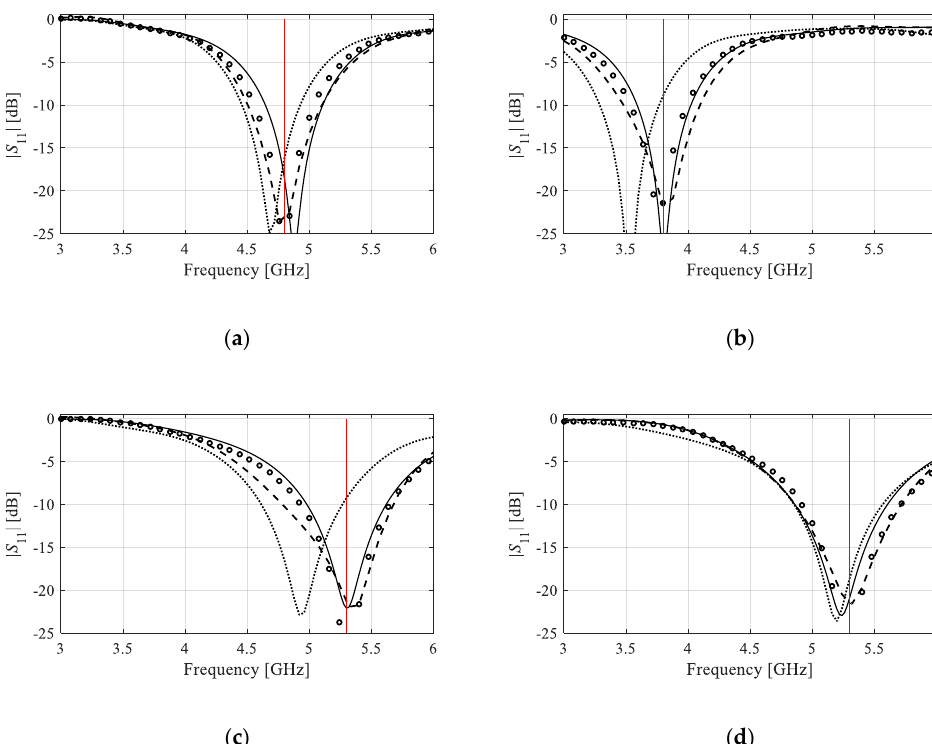
Figure 14. Optimization of the antenna of Figure 11 using the variable-thickness nested kriging